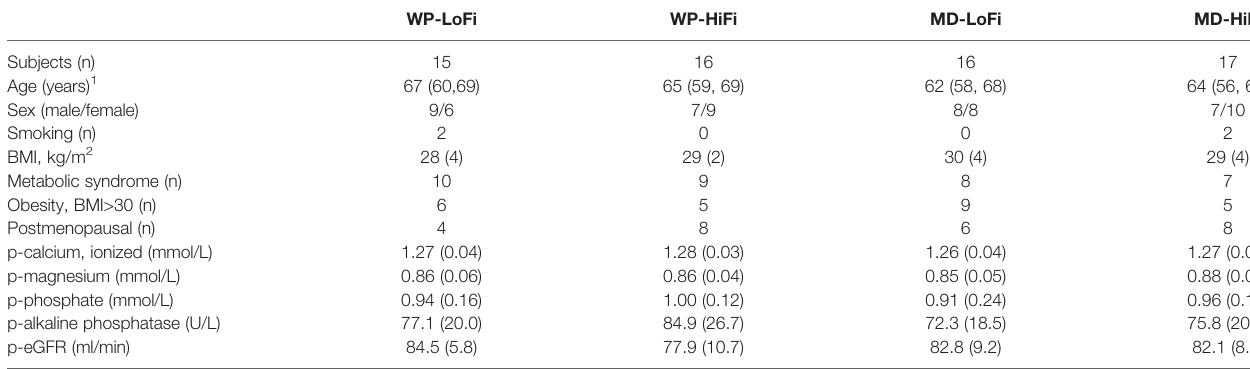
TABLE 1 | Baseline characteristics by randomization